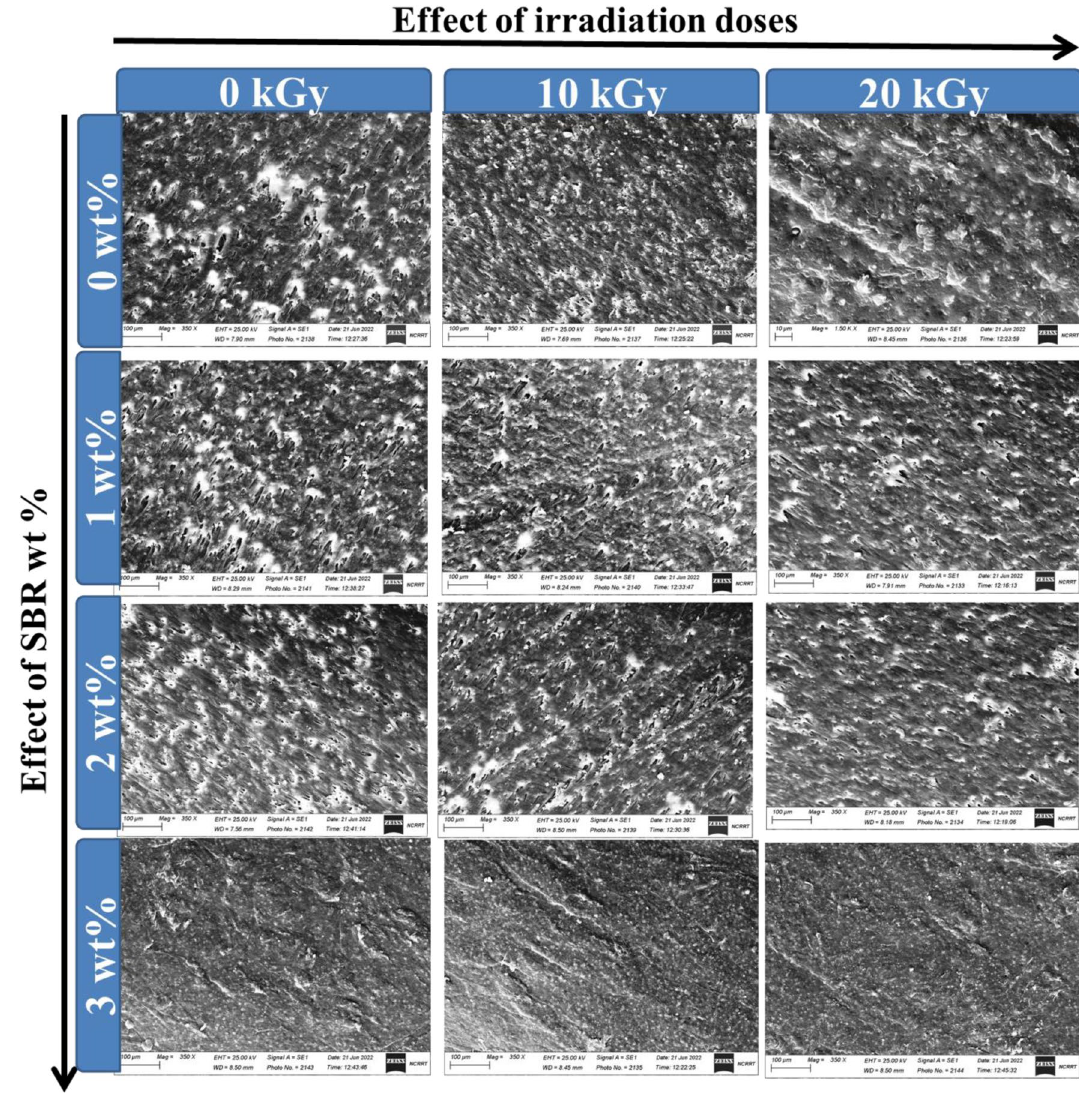
Figure 1. The effect of irradiation doses and SBR content in the surface morphological of (PVC/LLDPE)ZnO